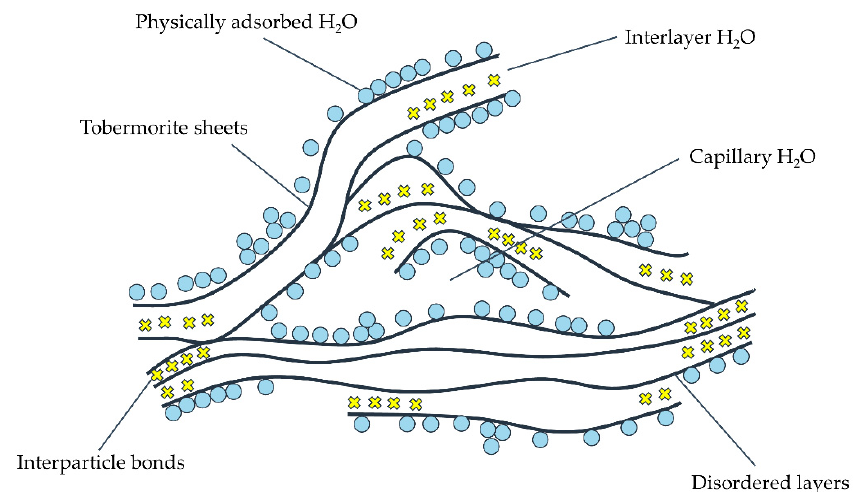
Figure 3. Feldman–Sereda model [83].